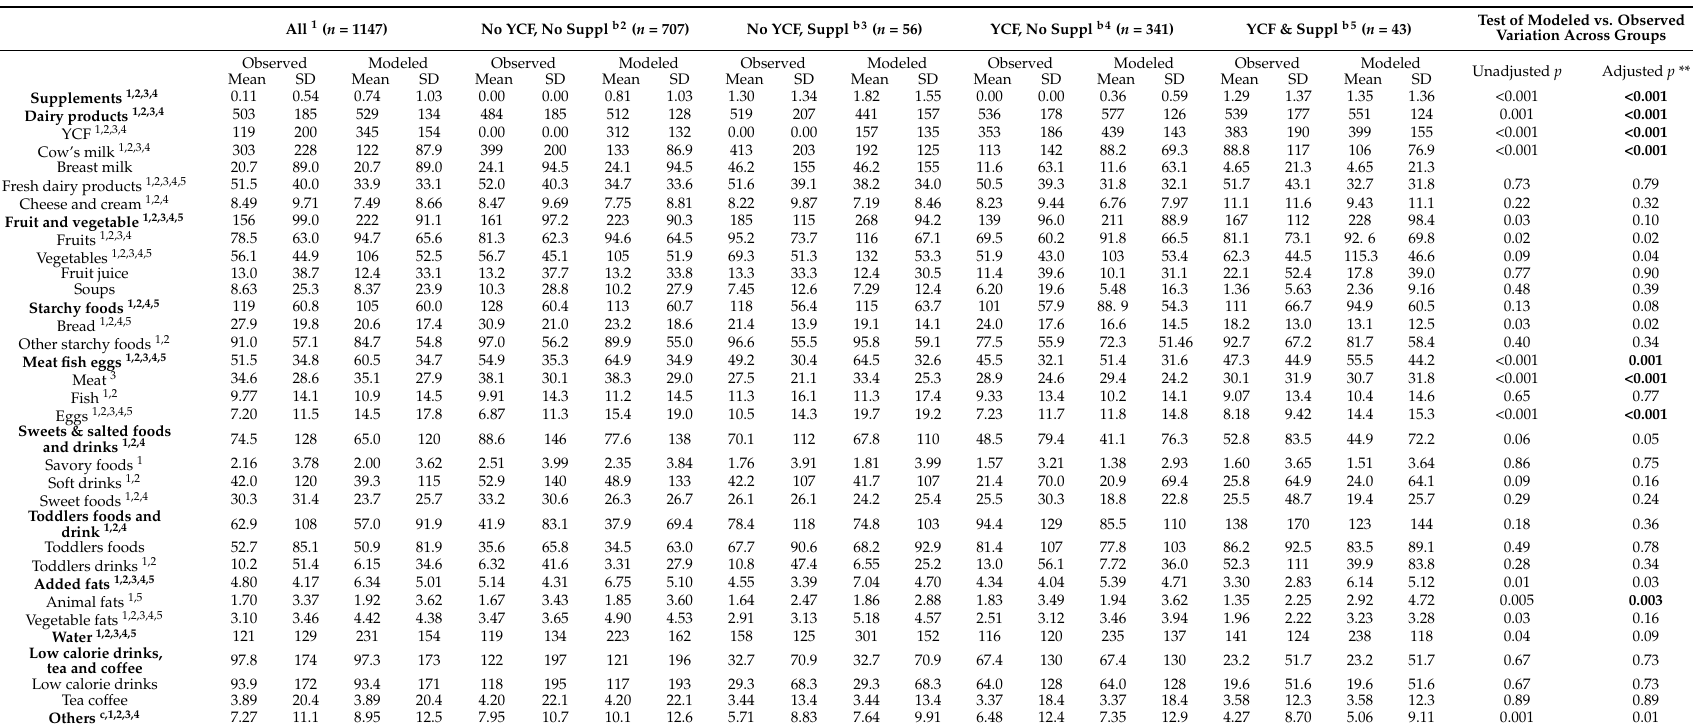
Table 3. Food categories and subcategories quantities (g/day) in observed diets and diets modeled with the all-foods models a , for the four groups of